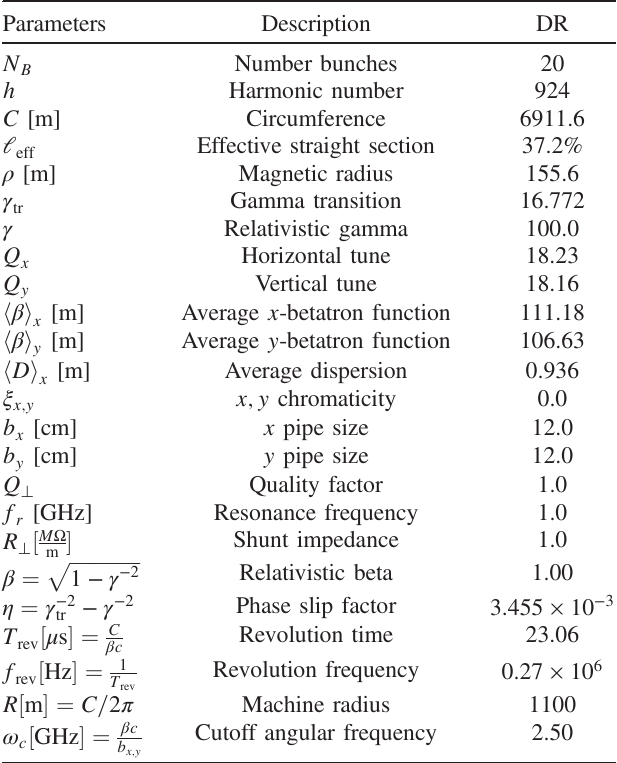
TABLE XIV. Input parameters above the first line. Assumed transversal impedance parameters between the lines. Calculated parameters below the last line. These parameters are the same for the different